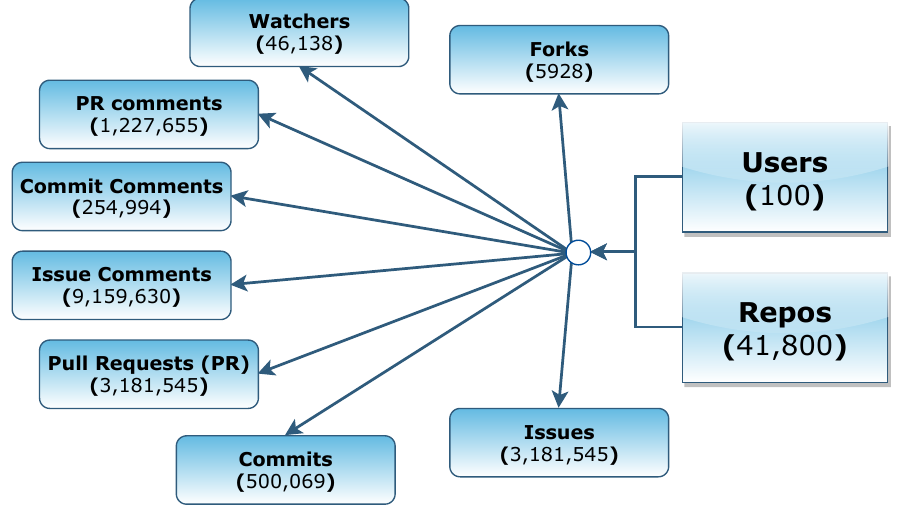
Figure 1. The dataset